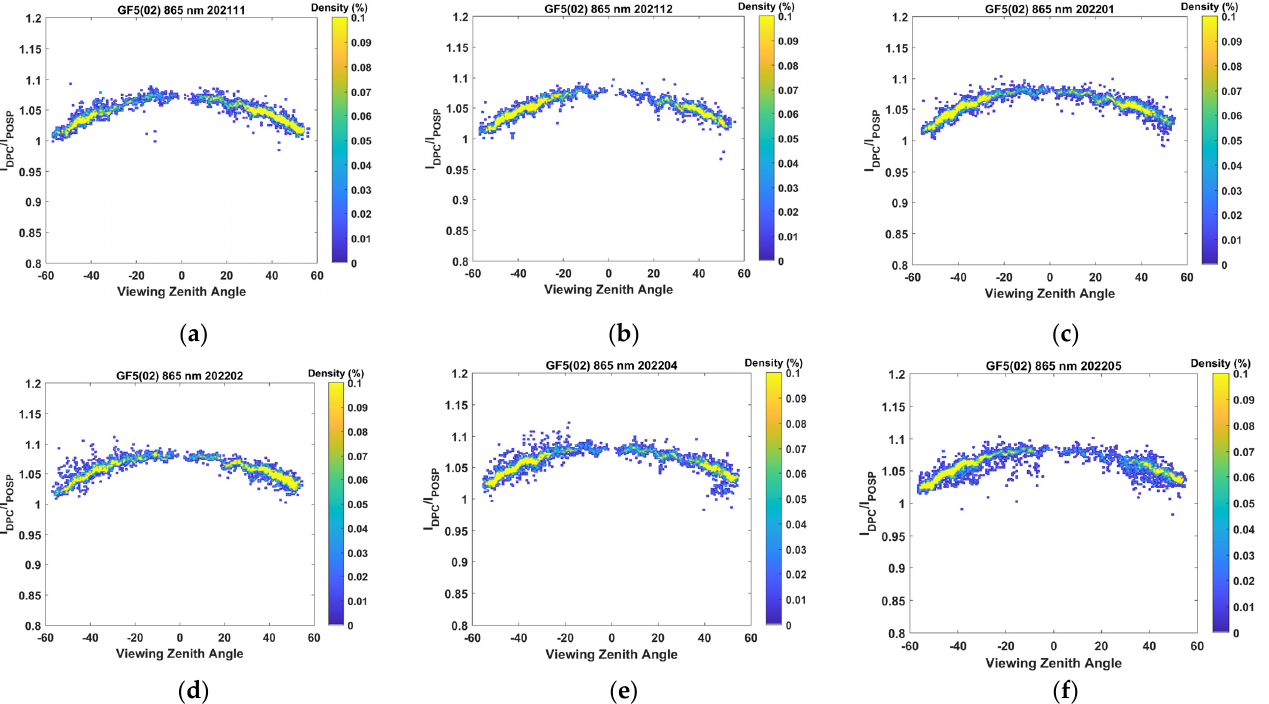
Figure 9. The ratio of DPC to POSP normalized radiance in the 865 nm band with different VZAs. These data pairs are selected for collection from ( a ) November 2021; ( b ) December 2021; ( c ) January 2022; ( d ) February 2022; ( e ) April 2022; and ( f ) May 2022 in DPC and POSP Level 1